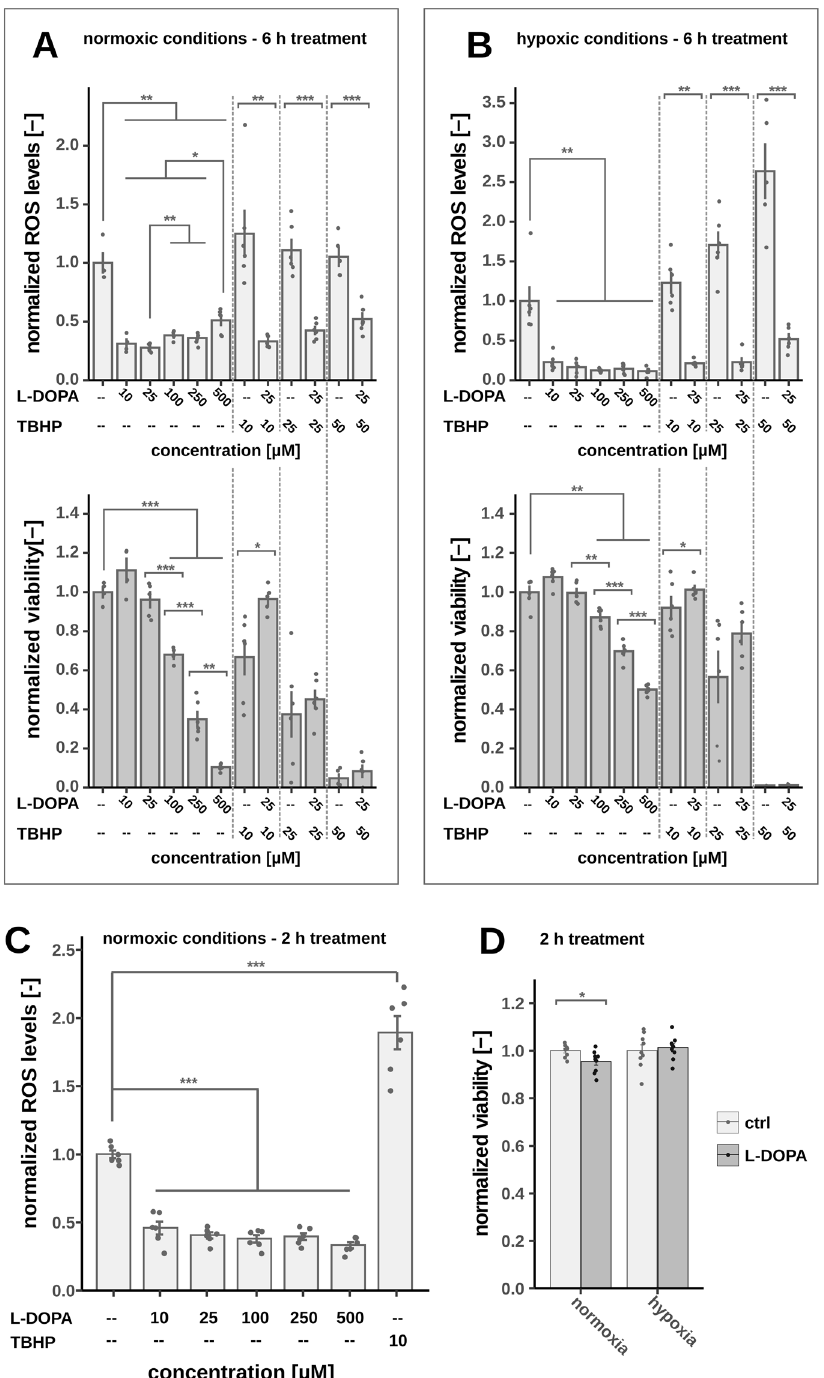
Fig. 2 Depending on oxygen tension, L-DOPA either acts as ROS producer or ROS scavenger. Combined NR viability assay and intracellular ROS assay after 6 h of L -DOPA treatment under normoxic ( A ) and hypoxic ( B ) conditions including TBHP as a positive control for increased ROS formation and cytotoxicity ( n = 5). C Intracellular ROS level after 2 h of L -DOPA treatment ( n = 6). D Normalized viability based on NR after 2 h of L -DOPA treatment (200 µM) under normoxic and hypoxic conditions ( n = 9). All experiments were done using fully differentiated LUHMES cells, mean, standard error and the single replicates are displayed, signi fi cance level were calculated using Welch ’ s t -test (* p -value < 0.05, ** p -value < 0.01, *** p -value < 0.001). Double-edged role of L -DOPA in intracellular ROS homeostasis effects were strongly decreased due to reduced oxygen tension (Fig. 1E, S1d). Based on these observations, we concluded that Based on our fi ndings that hypoxia limits auto-oxidation of most of the previously described neurotoxic effects of L -DOPA can L -DOPA, we were wondering if the catechol moiety of L -DOPA can be at least partially attributed to arti fi cially high levels of oxygen in even act as a ROS scavenger [22, 23]. Interestingly, L -DOPA in vitro experiments. treatment was able to reduce intracellular ROS down to 30% and Cell Death Discovery (2021)